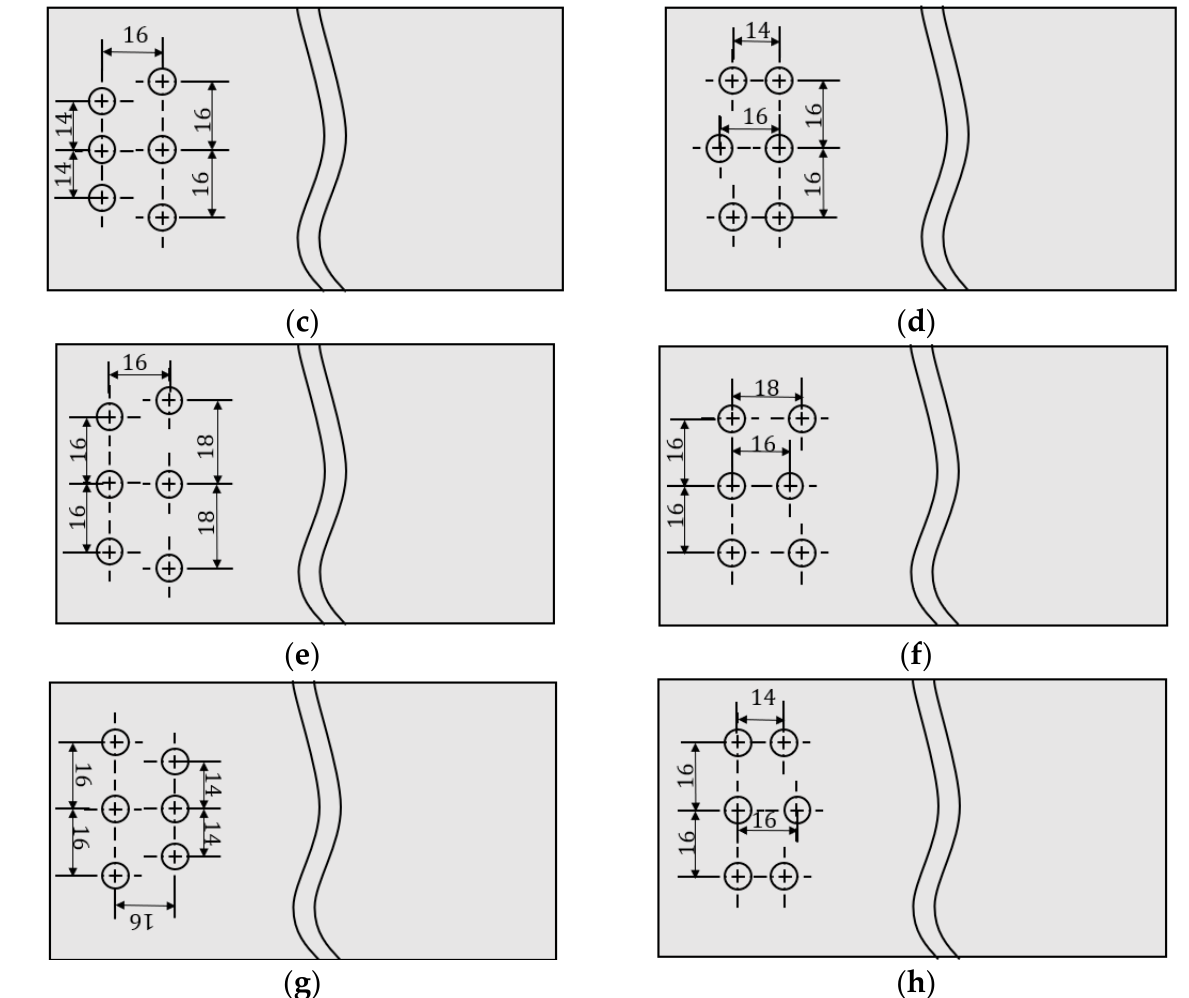
Figure 4. Different rivet layout design: ( a ) increase the outer rivet spacing (OSI); ( b ) increase outer rivet row spacing (ORSI); ( c ) decrease the outer rivet spacing (OSD); ( d ) decrease outer rivet row spacing (ORSD); ( e ) increase the inner rivet spacing (ISI); ( f ) increase inner rivet row spacing (IRSI); ( g ) decrease the inner rivet spacing (ISD); ( h ) decrease inner rivet row spacing (IRSD).